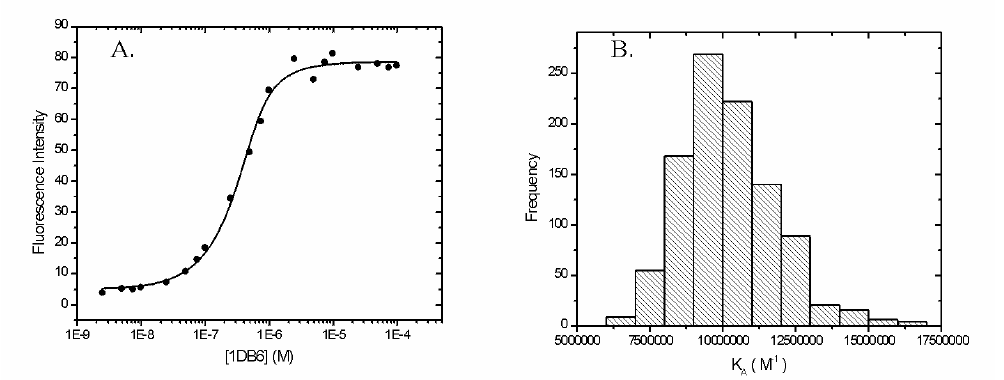
Figure 4. Fluorescence detected binding of ethidium to three L-argininamide recognizing DNA